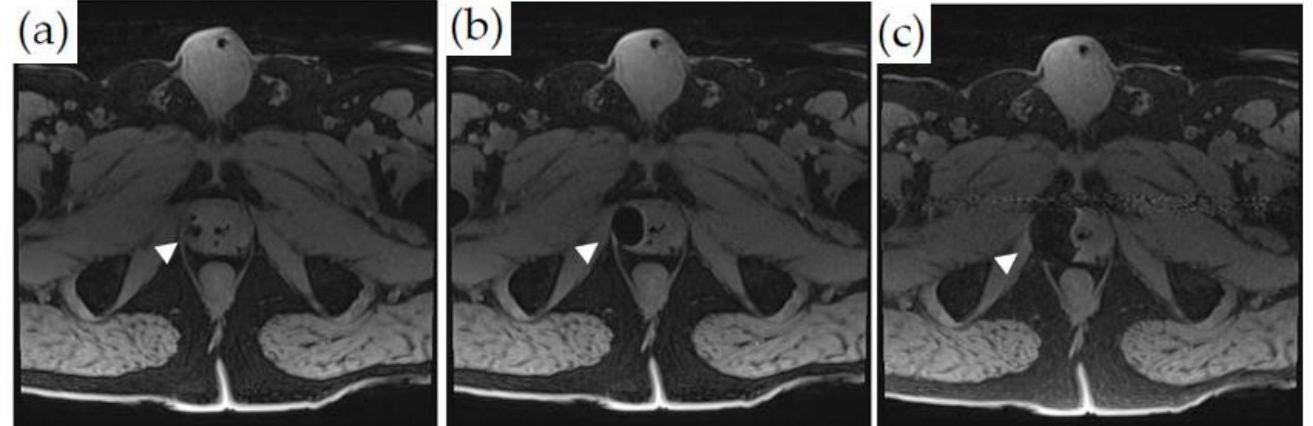
Figure 6. MRI-guided cryoablation and monitoring of ice-ball formation on axial T1-weighted fat- saturated images: ( a – c ) Ice-ball formation as a function of time in the right lateral peripheral zone of the prostate (white arrowheads). The untreated normal prostate tissue is visualized.